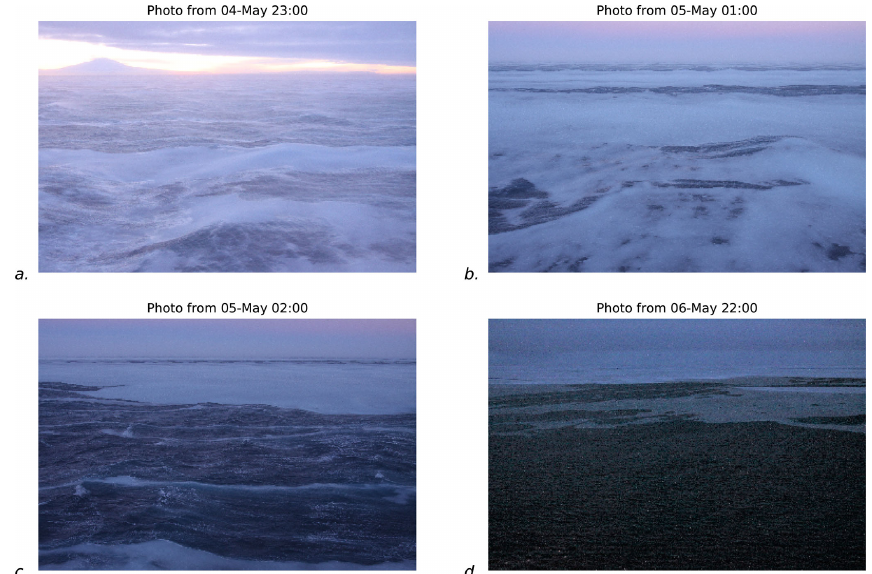
Figure 6. Images from RVIB Nathaniel B. Palmer as EISCam (Evaluative Imagery Support Camera) version 2. White areas in the water are loosely consolidated frazil ice crystals being actively formed during a katabatic wind event. Image (d) was brightened to allow for better